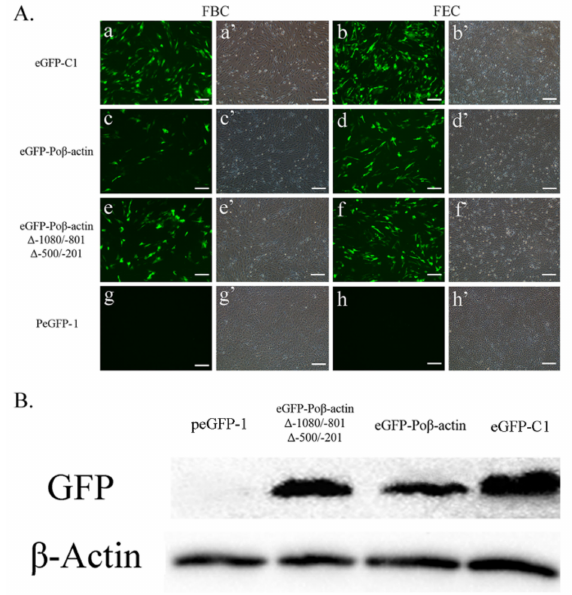
Figure 5. Expression of GFP driven by Po β -actin ∆ − 1080/ − 801 ∆ − 500/ − 201 in FBC and FEC